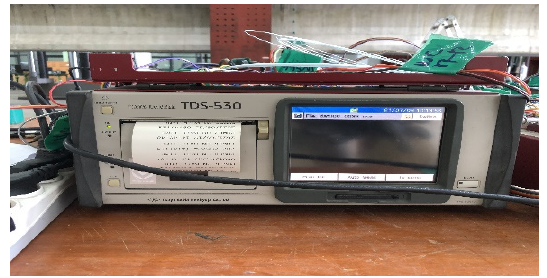
Figure 10. TDS-530 measuring instrument.